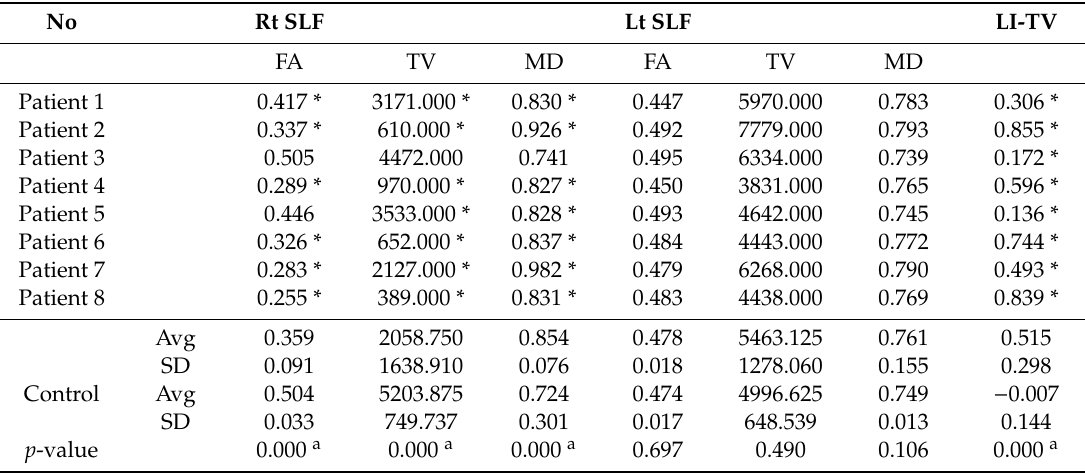
Table 4. DTI parameters and lateralization index-tract volume (LI-TV) of SLFs of patients ( n = 8) compared with the control group ( n = 16; a p < 0.05).